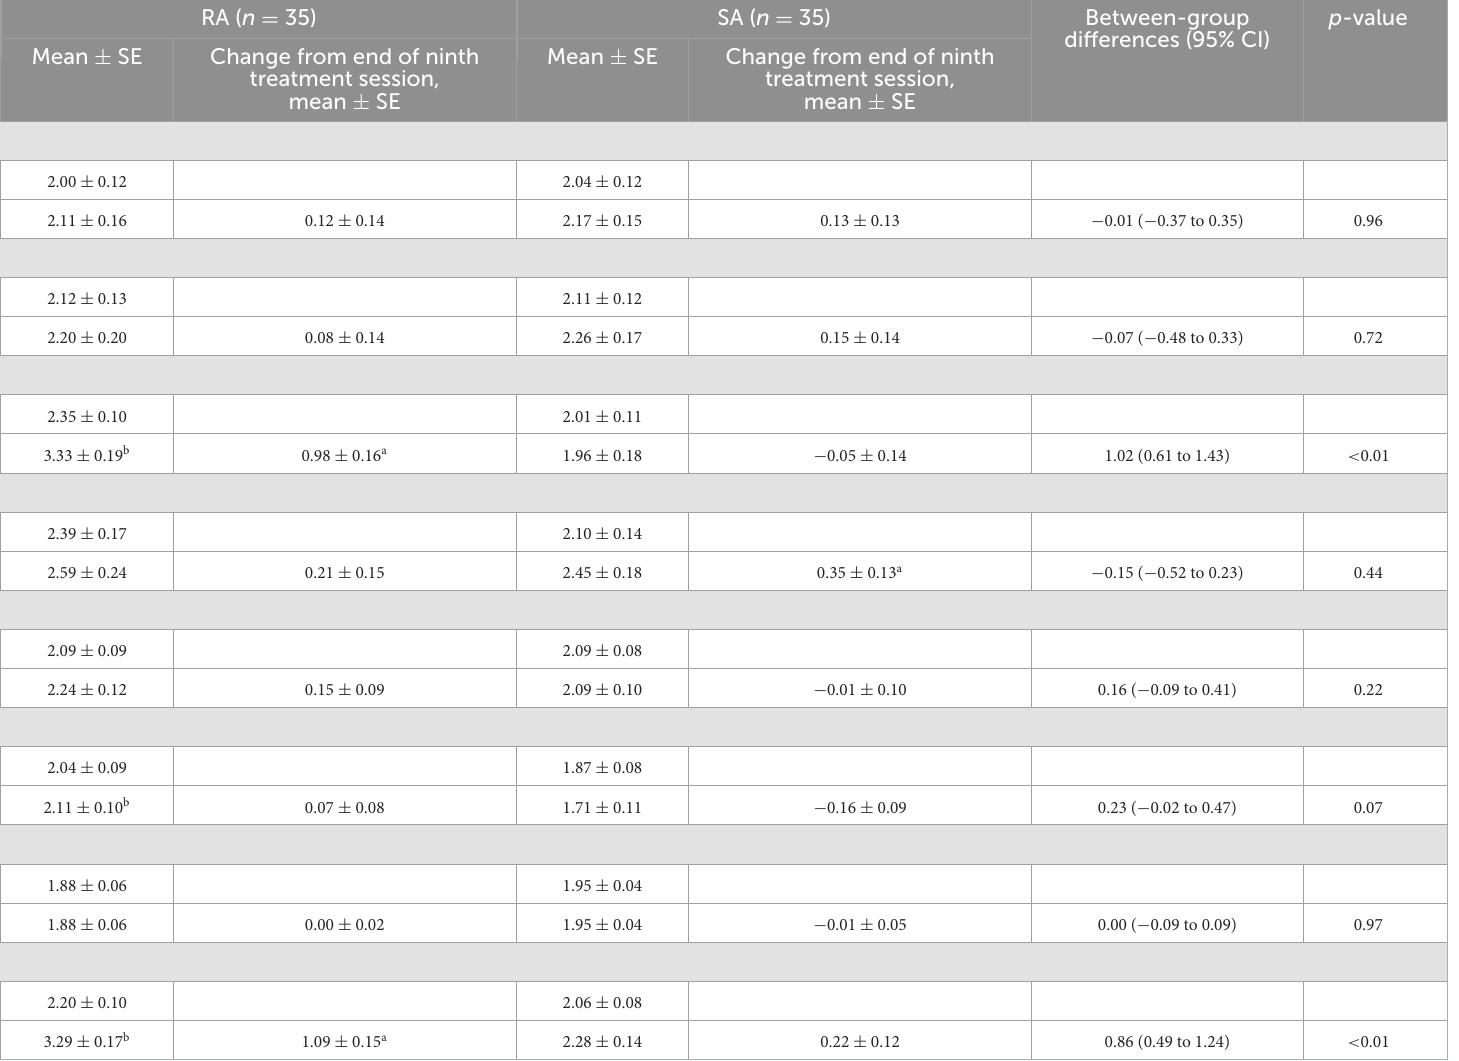
p -value differences (95% CI)